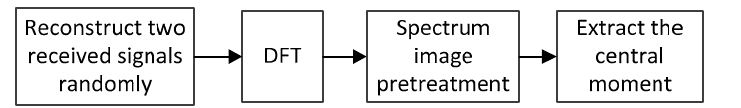
Table 1. Parameters of simulation signals.